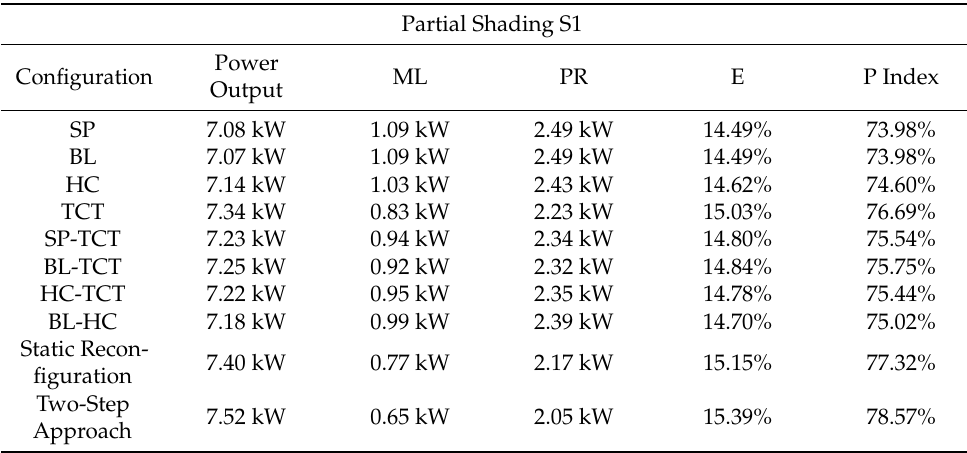
Table 4. Summarized data of the results obtained for the five partial shading